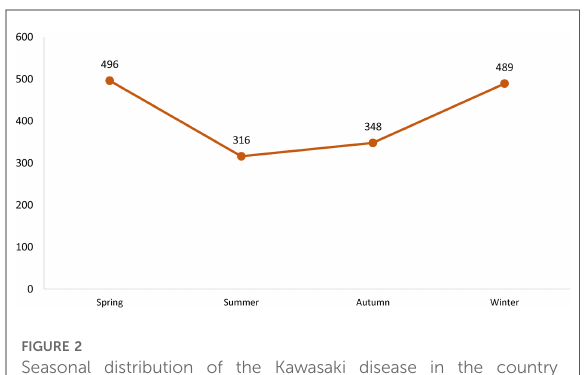
FIGURE 2 Seasonal distribution of the Kawasaki disease in the country between 2007 and